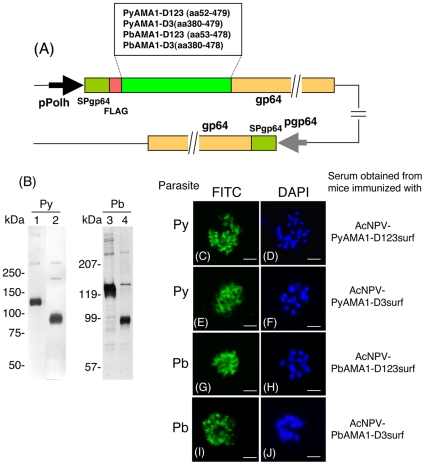
Construction and expression analysis of AMA1-BBVs.(A) Schematic diagram of four AMA1-BBV genomes. AMA1 was expressed as an AMA1-gp64 fusion protein under the control of the polyhedron promoter. Numbers indicate the amino acid positions of AMA1-gp64 fusion protein and endogenous gp64 protein. pPolh, polyhedrin promoter; SP, the gp64 signal sequence; FLAG, the FLAG epitope tag; pgp64, gp64 promoter. (B) Western blot analysis of AMA1-BBVs. AcNPV-PyAMA1-D123surf (lane 1), AcNPV-PyAMA1-D3surf (lane 2), AcNPV-PbAMA1-D123surf (lane 3) and AcNPV-PbAMA1-D3surf (lane 4) were treated with the loading buffer containing 1% 2-ME and examined using P. yoelii-hyperimmune serum (lanes 1 and 2), or P. berghei-hyperimmune serum (lanes 3 and 4). (C–J) Immunofluorescence patterns of sera obtained from mice immunized with four AMA1-BBVs on methanol-acetone fixed smears of erythrocytes infected with P. yoelii (C and E) and P. berghei (G and I). The smears were incubated with serum obtained from an individual mouse immunized either with AcNPV-PyAMA1-D123surf (C), AcNPV-PyAMA1-D3surf (E), AcNPV-PbAMA1-D123surf (G) or AcNPV-PbAMA1-D3surf (I), and antibody binding was detected with a secondary FITC-labeled antibody. Cell nuclei were visualized by DAPI staining on the corresponding smears (D, F, H and J). Scale bar, 10 µm.